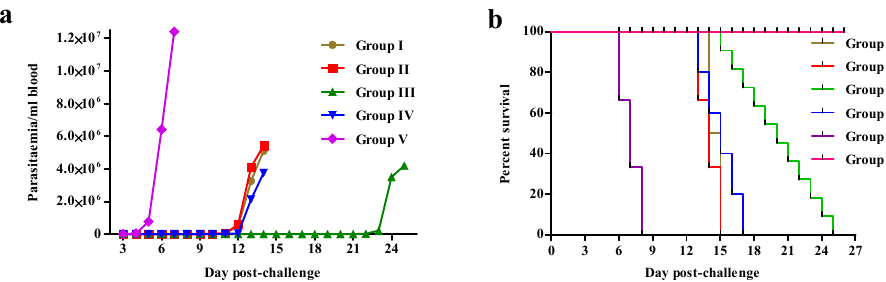
Figure 1. ( a ) The time course of parasitemia in different groups of mice post challenge. ( b ) Mouse survival following challenge by 1 × 10 2 T. evansi blood stream forms. Mice were immunized with rTePFR1 (Group I), rTePFR2 (Group II), an equimolar mixture containing rTePFR1 and rTePFR2 (Group III), T. evansi whole cell lysate (TeWCL) (Group IV) or FCA alone (Group V). Group VI was unimmunized and unchallenged. The boosters were administered on days 7 and 21. The mice were challenged with 1 × 10 2 live T. evansi through the intraperitoneal route on day 28 (shown here as 0 days post challenge). Parasitemia was monitored from day one post-challenge till death of the mice by counting trypomastigote forms in the peripheral blood obtained by sampling from the tail. Mean values ( n = 10) ± SEM are shown.